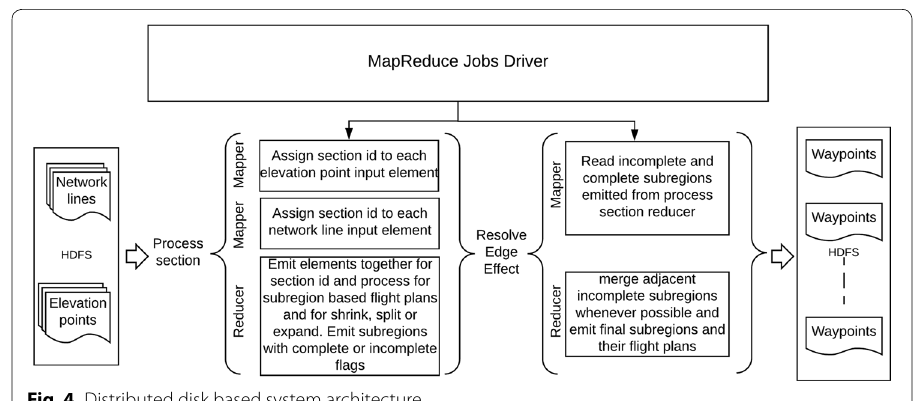
Fig. 4 Distributed disk based system